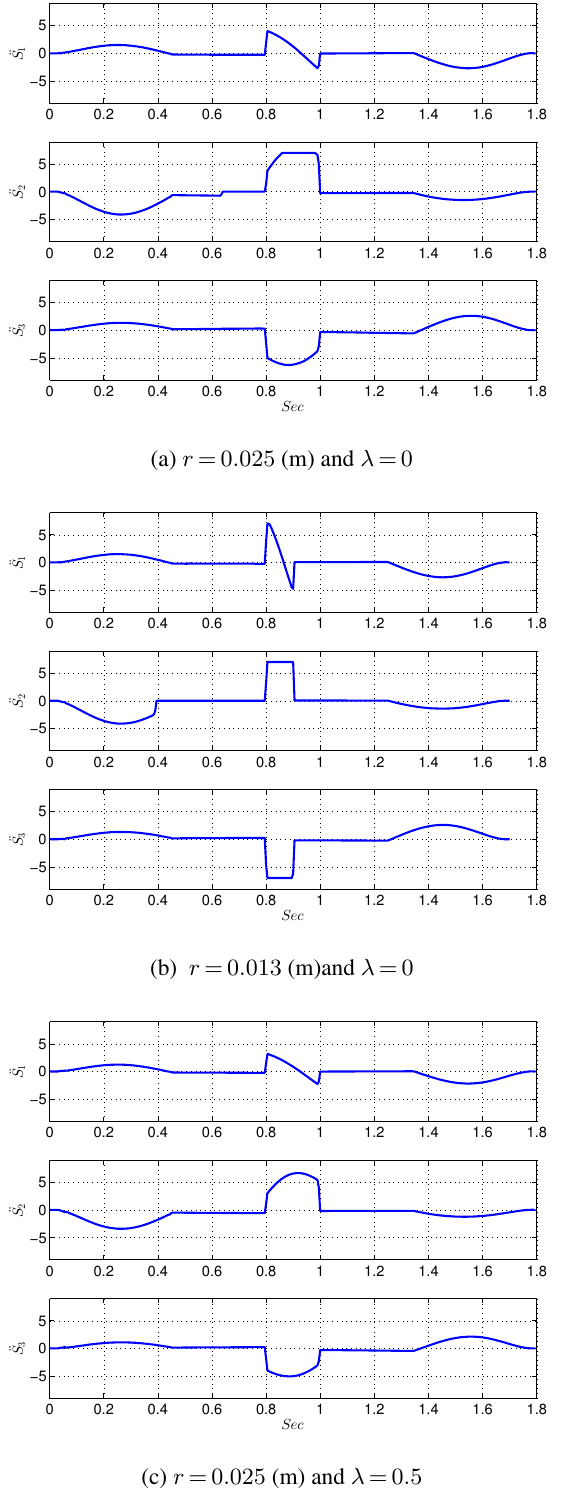
Fig. 6: The acceleration of the portable masses (in m/s 2 ). Figure 6. The acceleration of the portable masses (in ms − 2